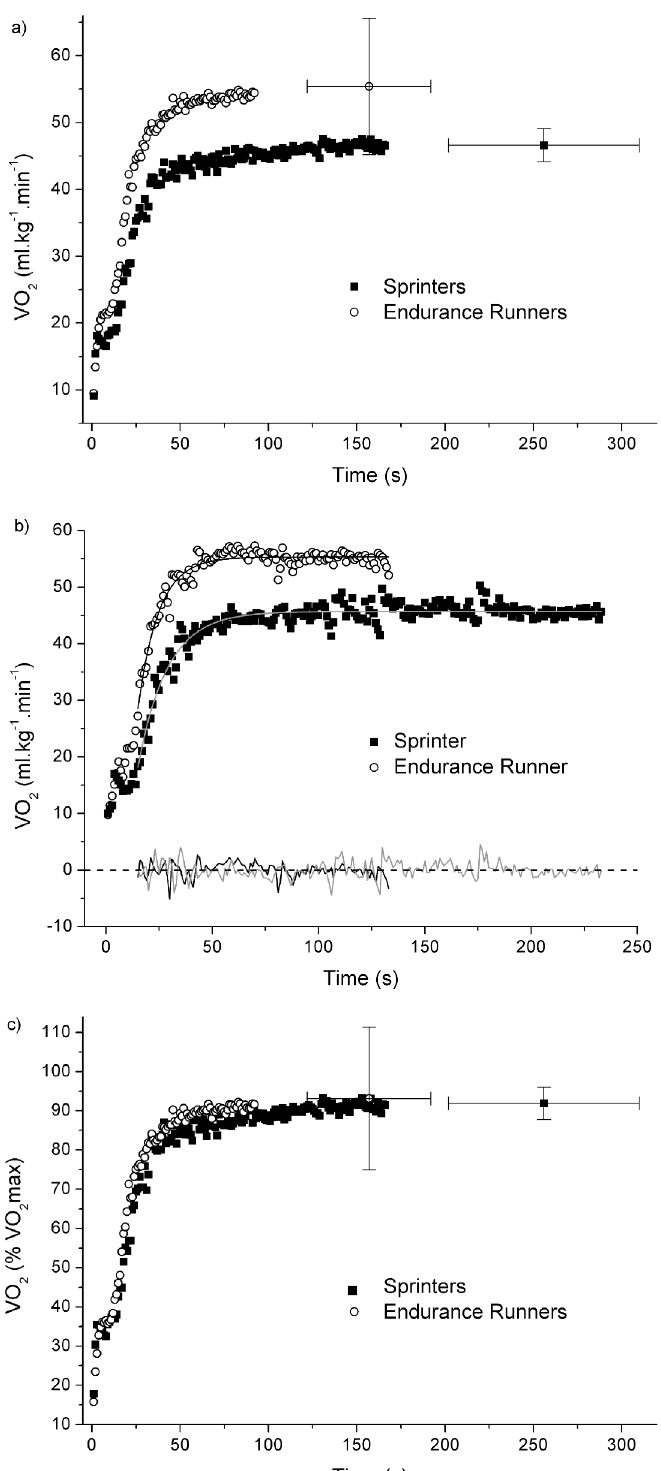
Fig 1. Pulmonary V ̇ O 2 response during the 110%MAV test for group mean data (a,b) and for a representative subject in each group (c). VO 2 was expressed in absolute and relative terms (%VO 2 max) in Fig 1A and 1B, respectively. In Fig 1A and 1B, data were matched at the shortest time to exhaustion recorded in each group. Moreover, the mean ± SD of the asymptote (i.e. amplitude + V ̇ O 2 rest) and time to exhaustion are also shown. In Fig 1C, the exponential fits of the data and the residuals were also